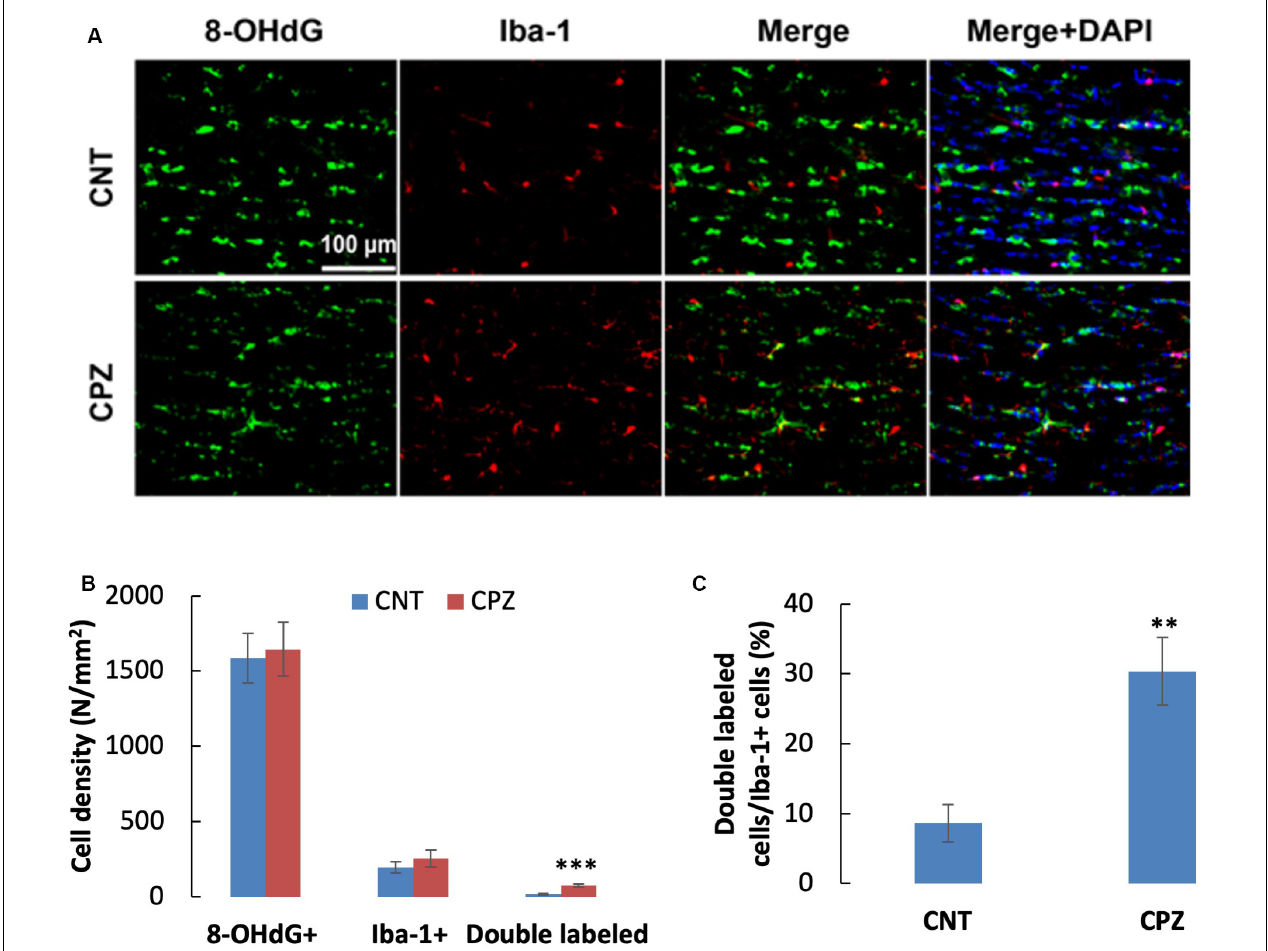
FIGURE 4 | (A) Representative photographs cells labeled by the antibody to 8-OHdG, antibody to Iba-1, and double labeled cells by the two antibodies. (B,C) Bar charts showing the statistical analysis results of the immunofluorescent staining. Data are expressed as means ± SD ( n = 6/group). ** p < 0.01, *** p < 0.0001. The comparisons were made between CNT and CPZ groups by performing t -test or chi-square test (percentage of double labeled cells in iba-1 +